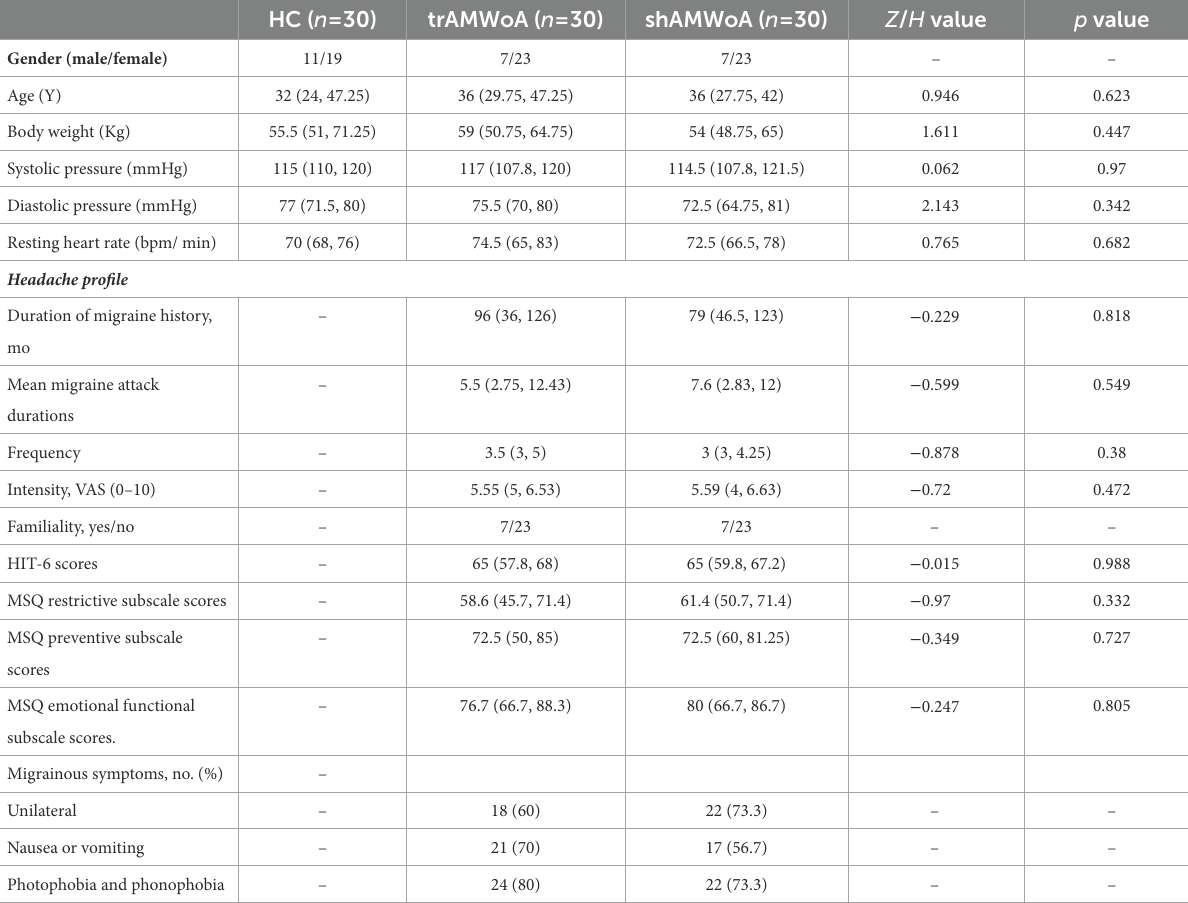
TABLE 1 Demographic and clinical characteristics of study participants ( M [Q25 ，